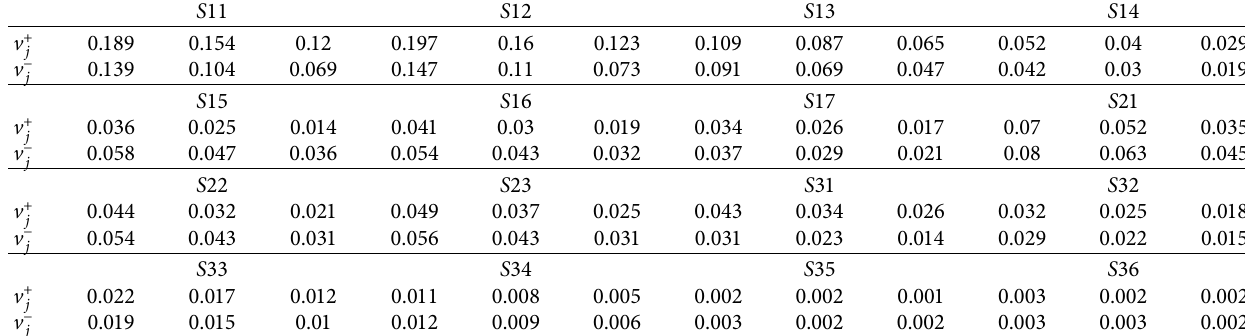
Table 16: Calculations of d +